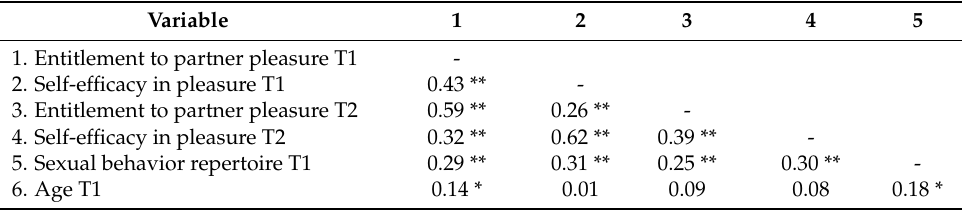
Table 2. Pearson’s correlations between the two sexual subjectivity subscales, sexual behavior repertoire and age ( N = 295).